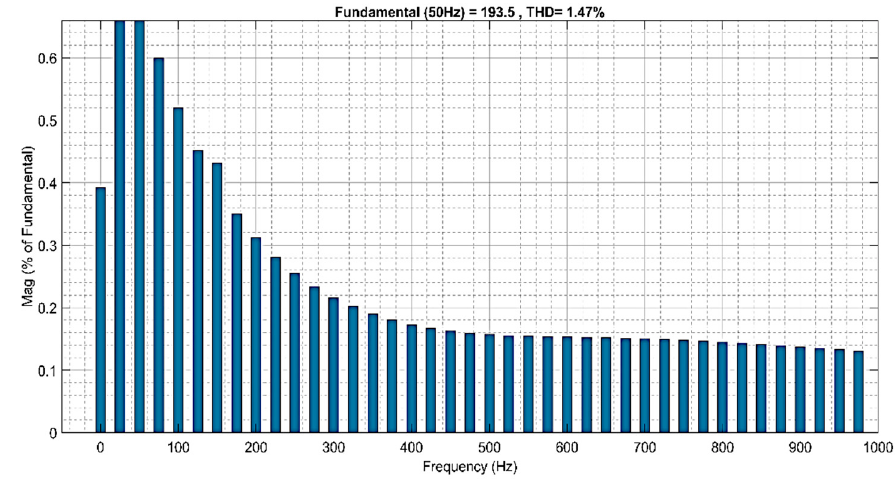
Figure 14. Output voltage waveform.